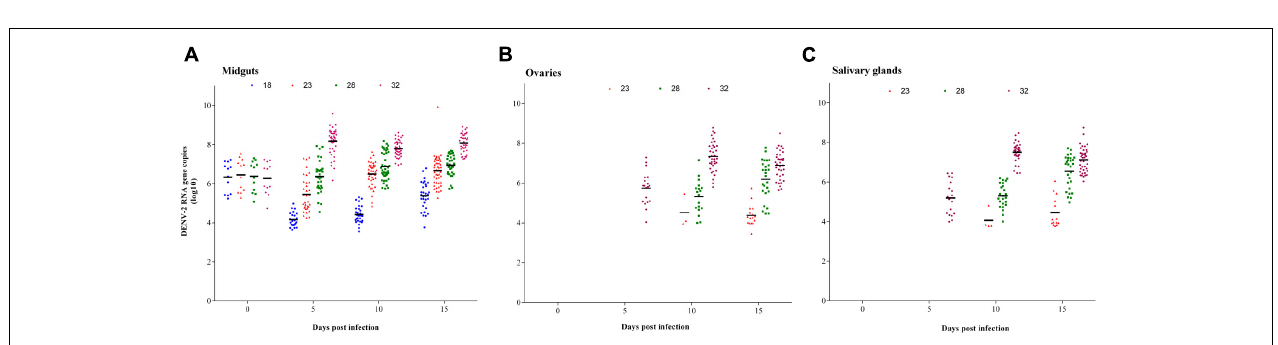
FIGURE 2 | Comparison of vector competence of Ae. albopictus between constant and fluctuating temperatures. The IR, DR, and PTR of Ae. albopictus reared at 28 ◦ C and 28–23–18 ◦ C were compared at 0, 5, 10, and 15 dpi. (A) IR; (B) DR; (C) PTR. Error bars represent 95% CI. ∗ P < 0.05; ∗∗ P < 0.01.